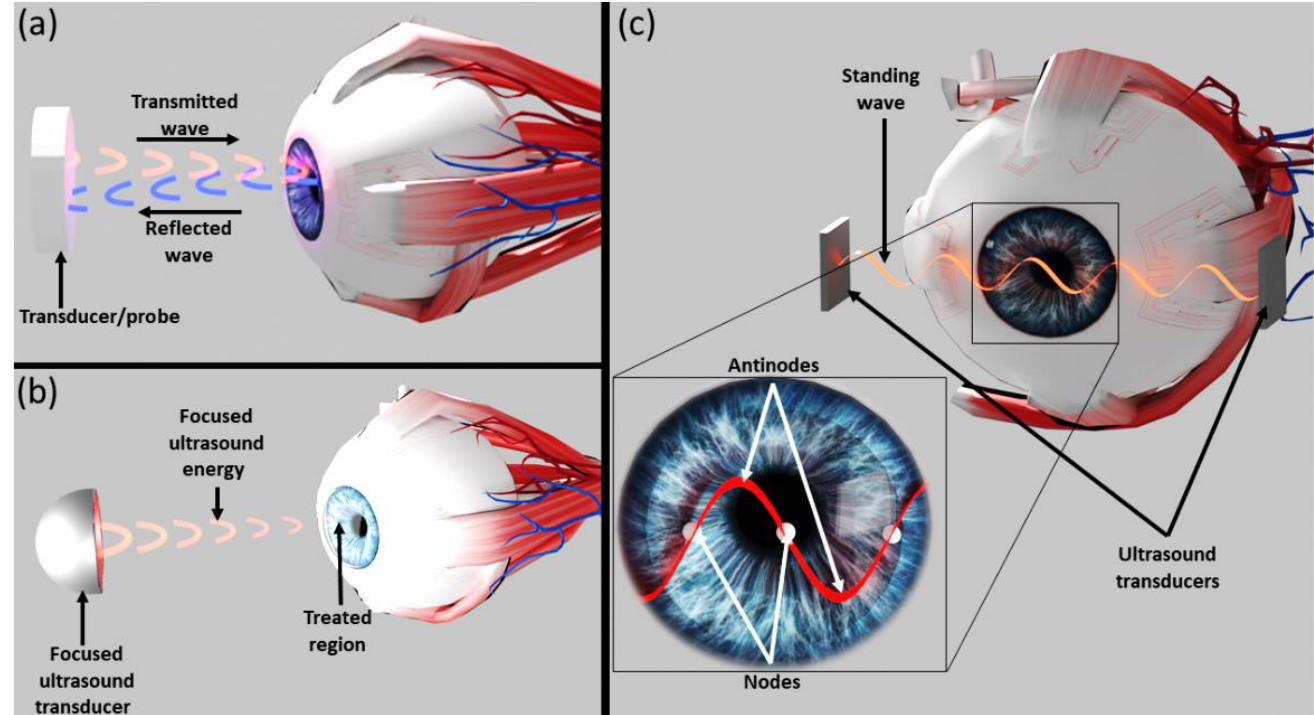
Figure 1. Illustration of various methods that utilize acoustic waves in ophthalmology. ( a ) Ultrasonic waves used to image the location and characteristics of various eye components. ( b ) High-intensity focused ultrasound used to destroy ocular tissue ablation. ( c ) The novel method for interocular particle acoustic manipulation suggested in this manuscript. Acoustic transducers are used to create standing acoustic waves that direct intraocular particles towards their nodal areas.